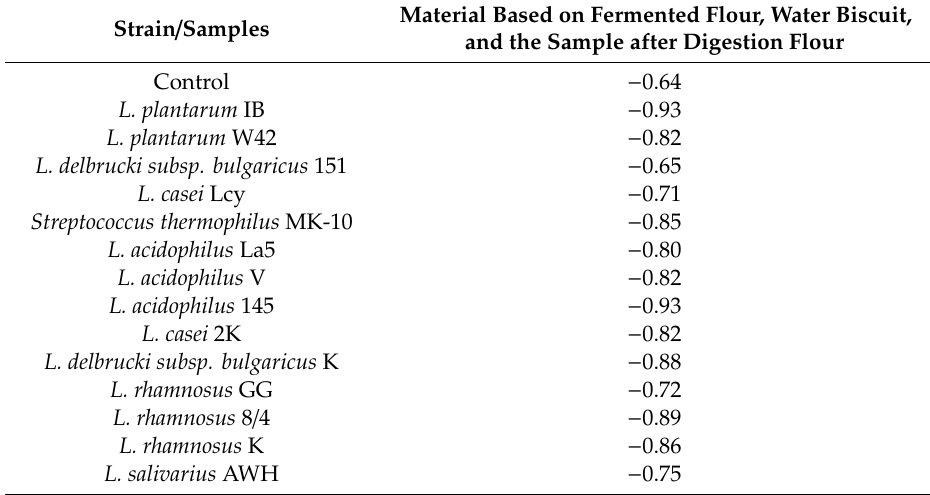
Table 5. The values of the Pearson correlation coe ffi cient between IC 50 and TPC of fermented flour, water biscuit, and the sample after digestion for each applied lactic acid bacterium (LAB) ( p < 0.05). Material Based on Fermented Flour, Water Biscuit, Strain / Samples and the Sample after Digestion Flour Control −